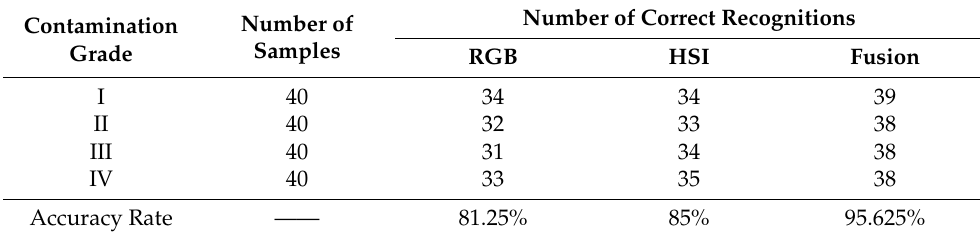
Table 2. Results of contamination grade